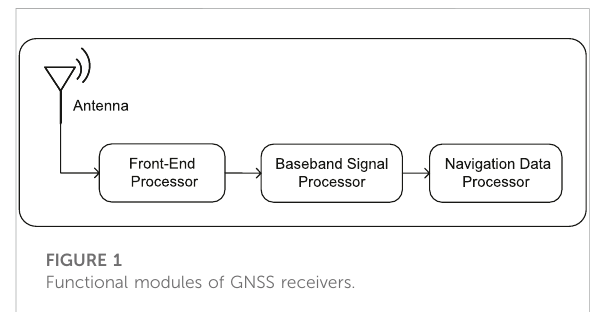
FIGURE 1 Functional modules of GNSS